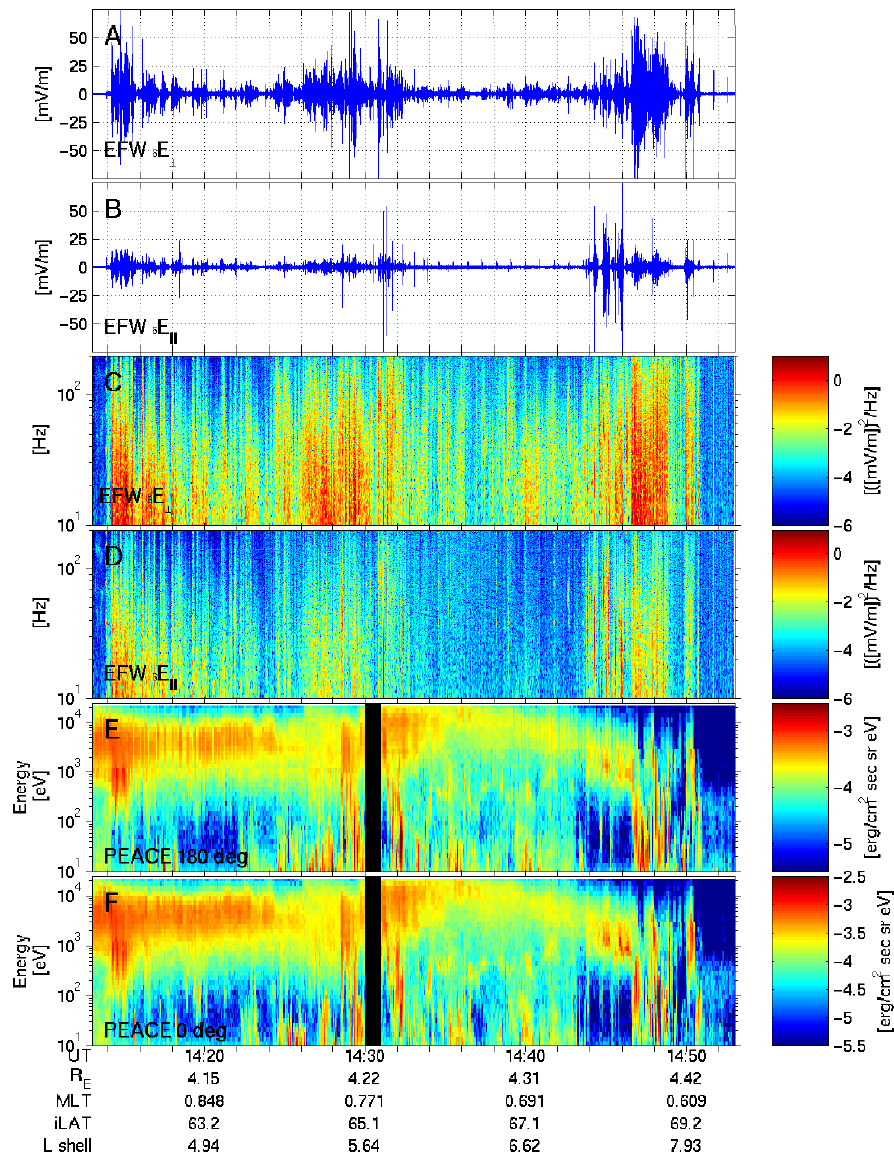
Fig. 1. Data observed by Cluster spacecraft 4 during a crossing of an auroral magnetic field line: electric field (10–180Hz) perpendicular (panel A ) and parallel (B) to the ambient magnetic field; spectra of perpendicular (C) and parallel (D) electric field; energy spectra of downgoing (E) and upgoing (F) electrons. Waves with a large parallel component of the electric field are found in regions without cold electrons. The H + gyrofrequency and the lower hybrid frequency are 7.6Hz and 160Hz, respectively.